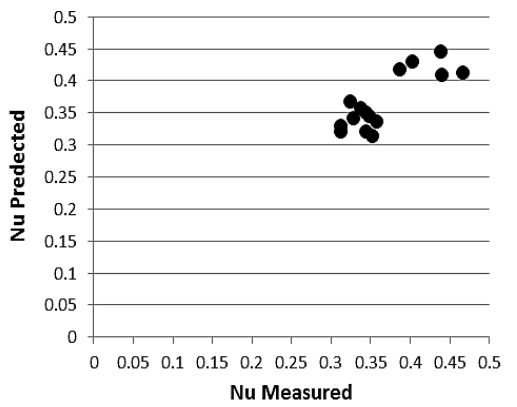
Figure 17. Relation between predicted and measured Nu.